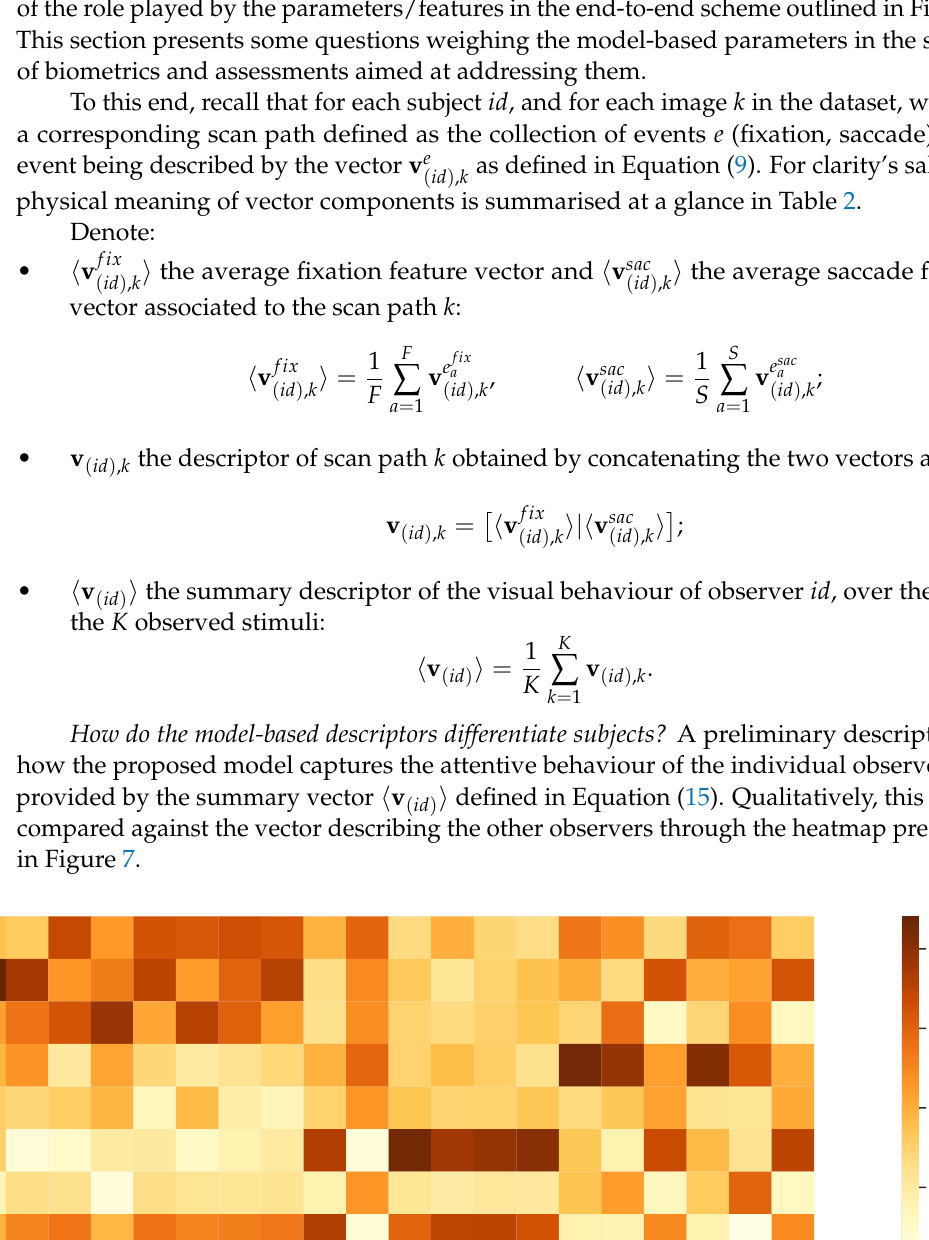
v ( id ) for subject id ; numeric values of vector components (cid:104) (cid:105)